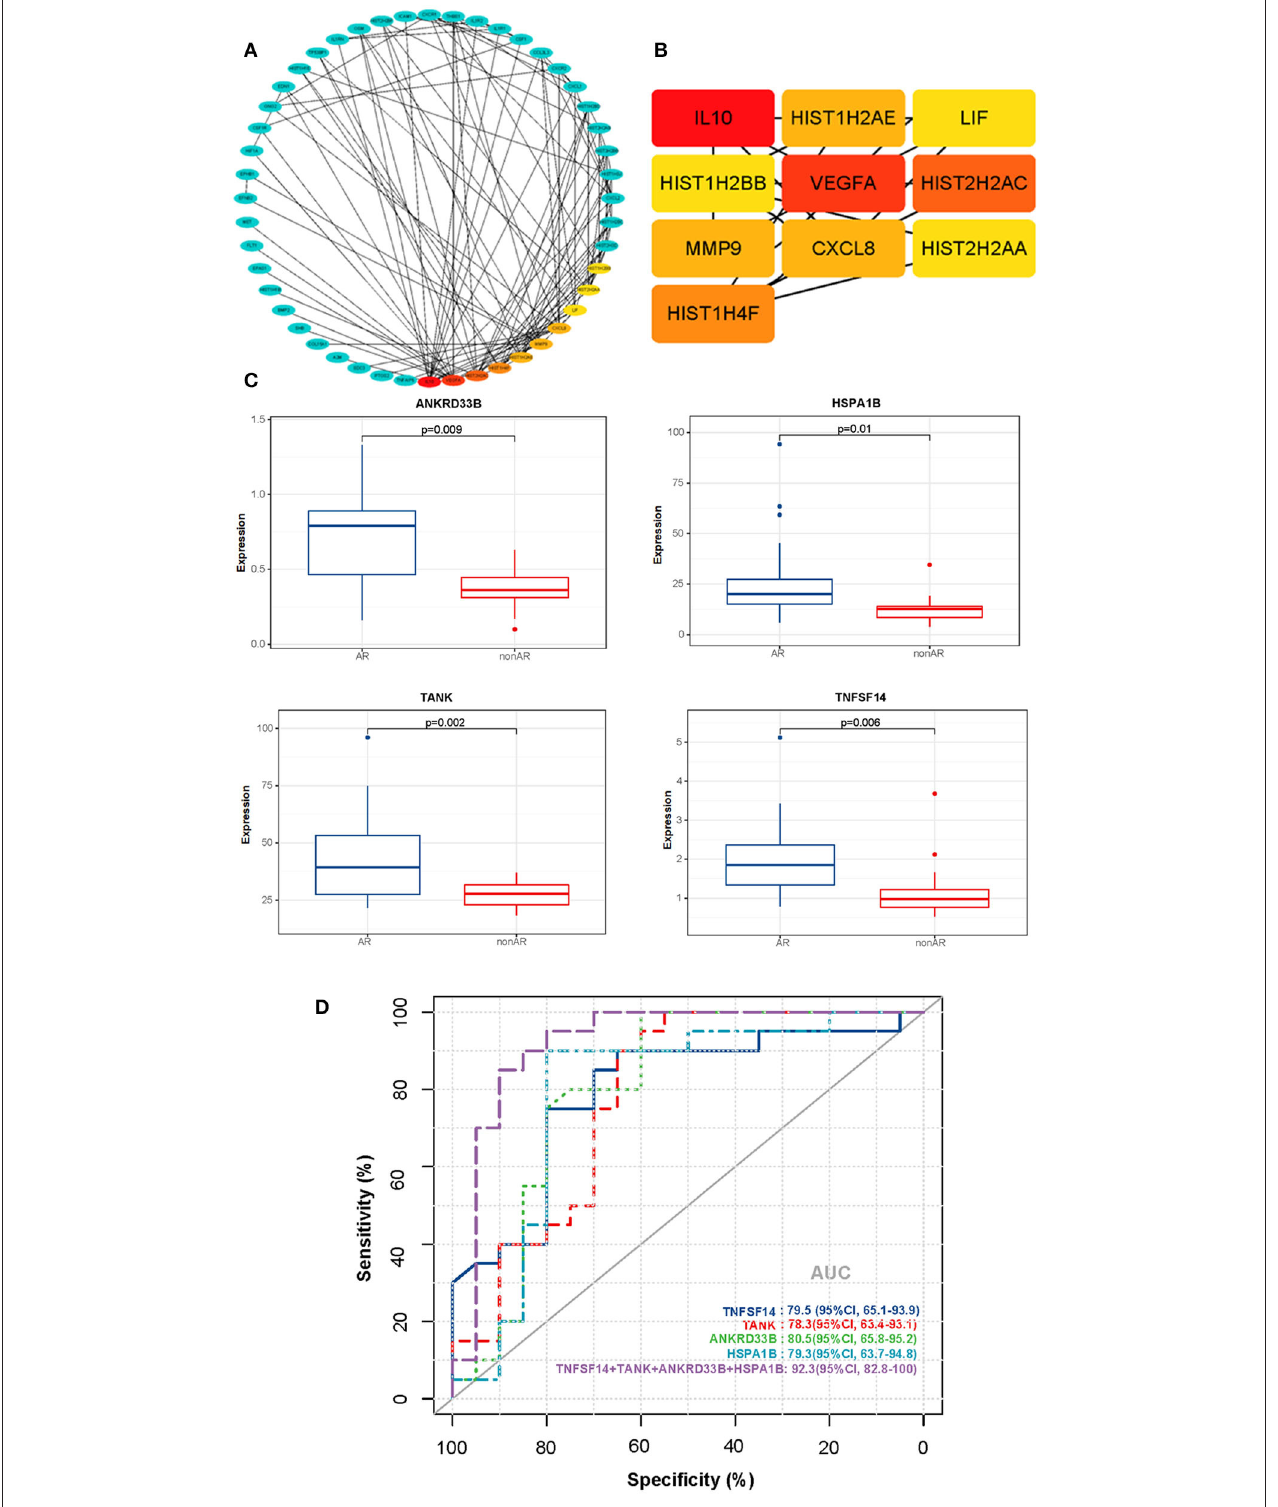
FIGURE 7 | PPI networks of DEGs and ROC curves for diagnosis of AR. (A) The PPI network of DEGs detected in AR vs. non-AR groups was performed with Cytoscape. (B) The hub genes were identified by the CytoHubba plugin with the top 10-degree score. (C) Box plots of the mRNA expression. (D) ROC curves were constructed to determine the diagnostic power of DEGs for AR. TNFSF14: AUC 79.5 (95% CI, 65.1–93.9); TANK: AUC 78.3 (95% CI, 63.4–93.1); ANKRD33B: AUC 80.5 (95% CI, 65.8–95.2); HSPA1B: AUC 79.3 (95% CI, 63.7–94.8); NFSF14 + TANK + ANKRD33B + HSPA1B: AUC 92.3 (95% CI, 82.8–100).